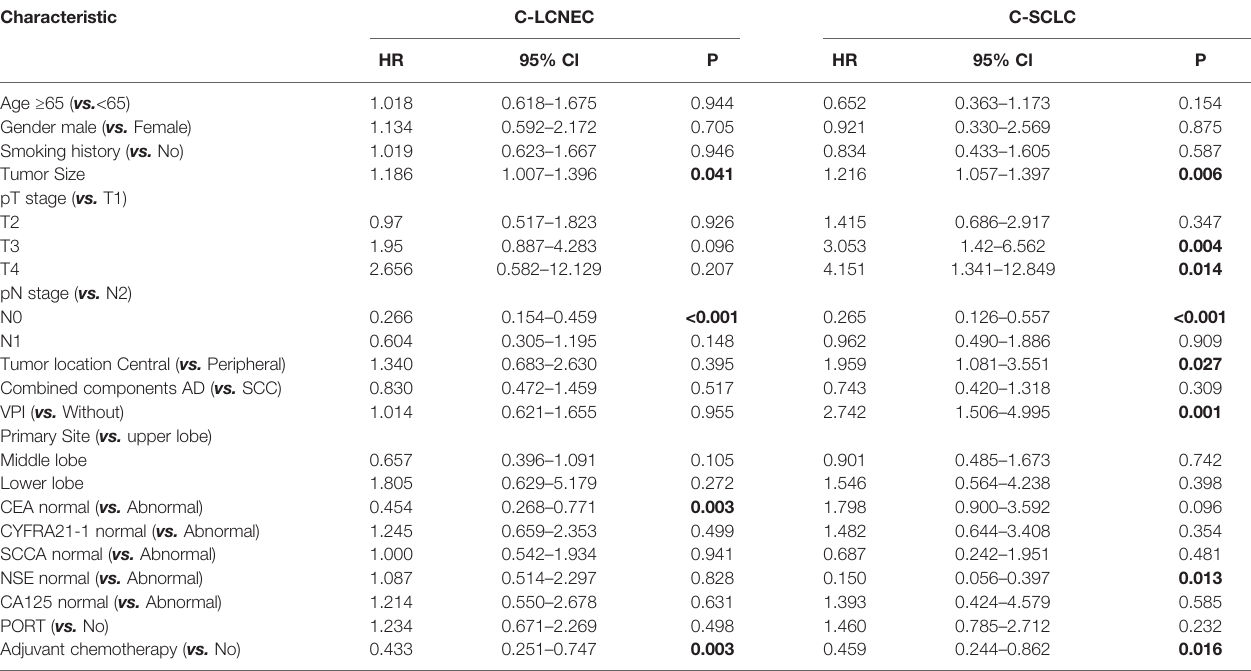
TABLE 2 | Impact of clinical characteristics on disease-free survival in patients with resected C-LCNEC and C-SCLC by univariate Cox analysis.